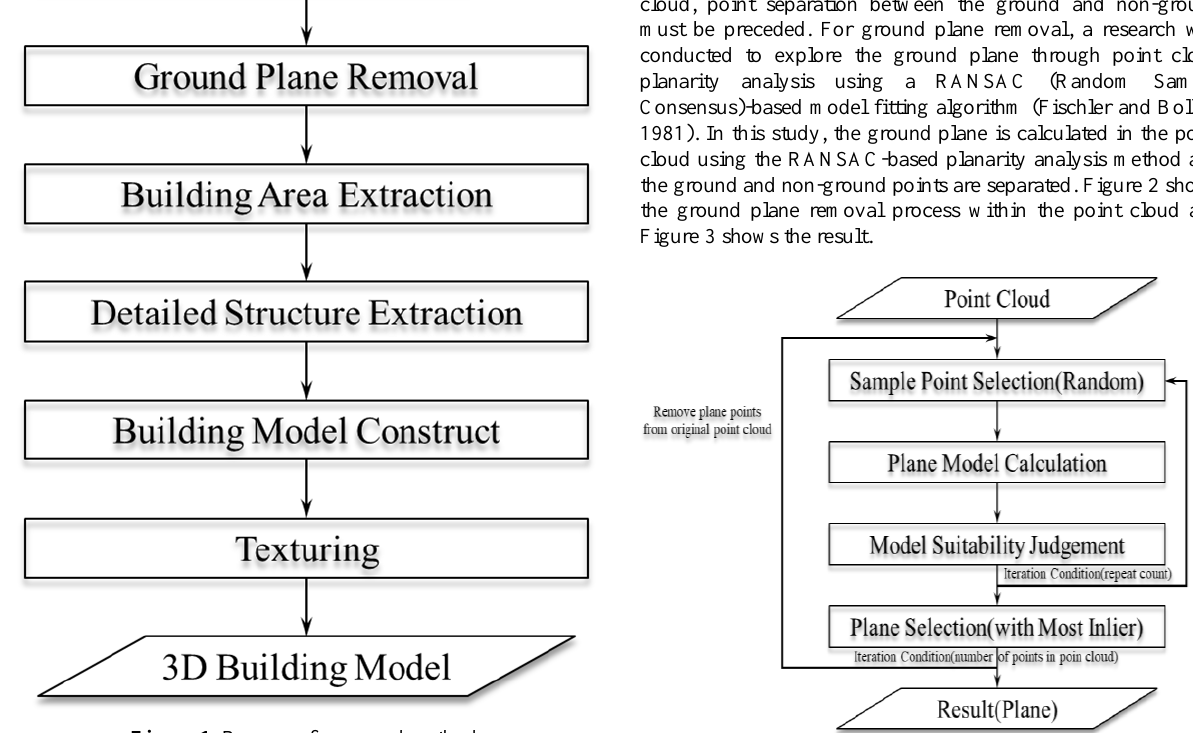
Figure 1. Process of proposed method .